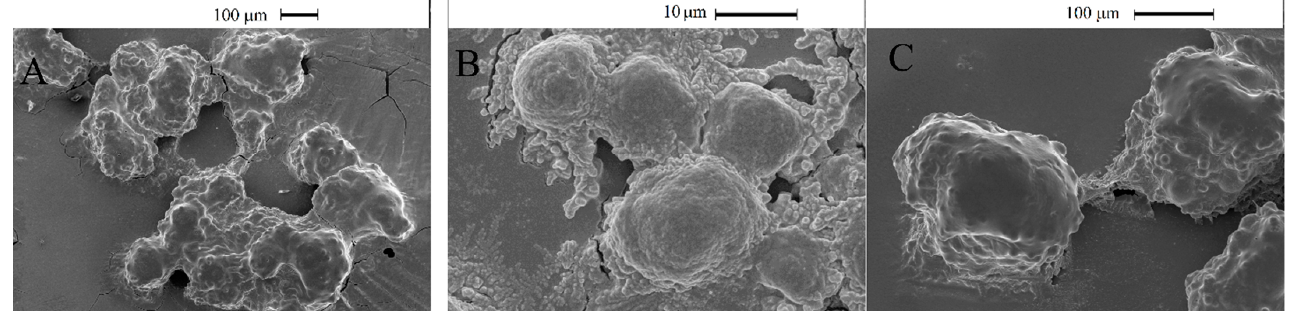
Figure 5. SEM observation of the: ( A ) individual Hep-G2 clusteroids, ( B ) individual HUVEC clusteroids, and ( C ) co-culture of Hep-G2 and HUVEC clusteroids at a cell ratio of 5:1. The cells kept growing in the Matrigel before the gels were